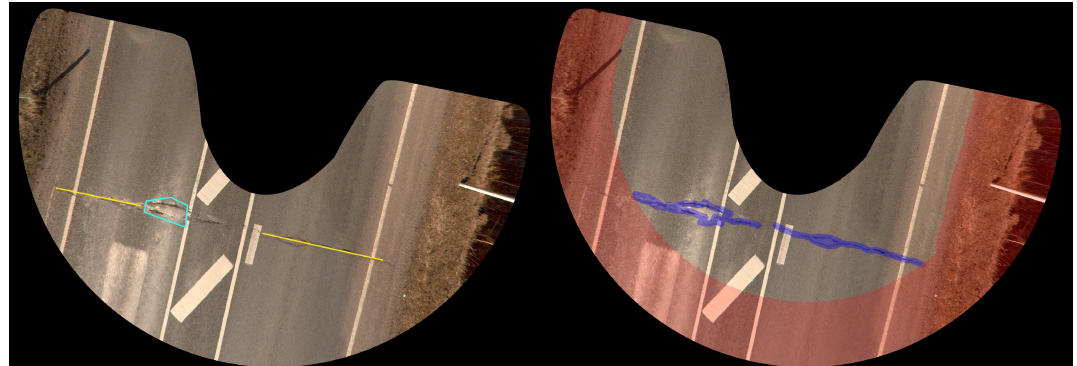
Figure 6. Left: The original defect layer. Displayed are two annotated transverse cracks (yellow) and a patch (cyan). Right: Redigitized image. The part of the orthoframe removed from further analysis is marked with red color. Note that the roadside area on the right has been cut off by digitization. The annotated defects are highlighted with blue color. One can see the difference in annotation accuracy in these two